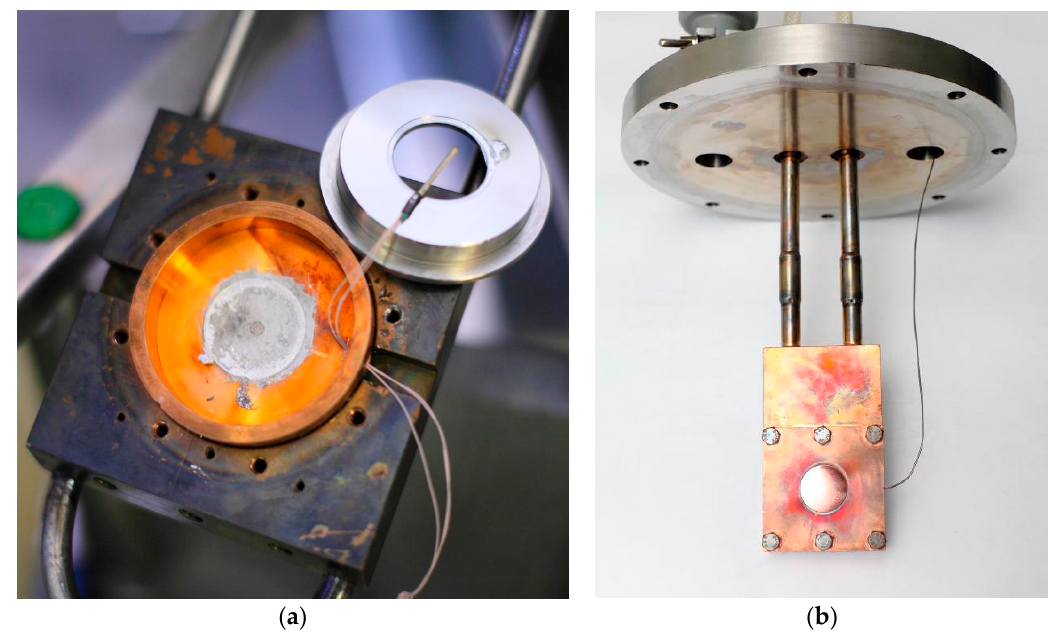
Figure 2. Images of the heat-removing surface used in the first ( a ) and second ( b ) series of experiments.